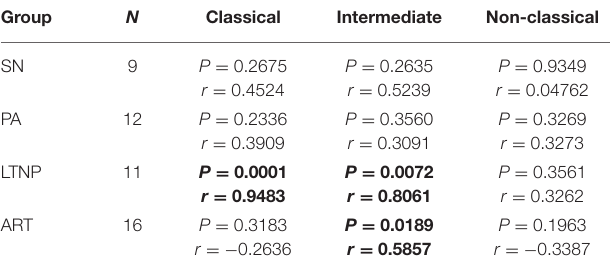
TABLE 3 | Association of CD4 and HLADR per-cell expression on monocyte subsets. Group N Classical Intermediate